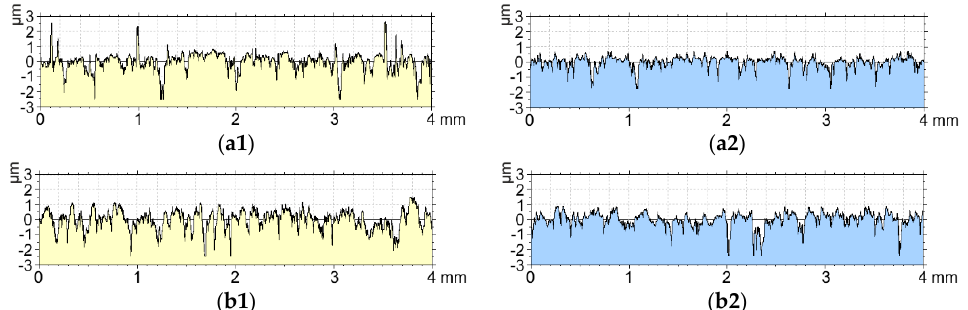
Figure 15. Roughness profiles: ( a ) sample C, ( b ) sample G, 1 —before the tribological test, 2 —after the tribological test.